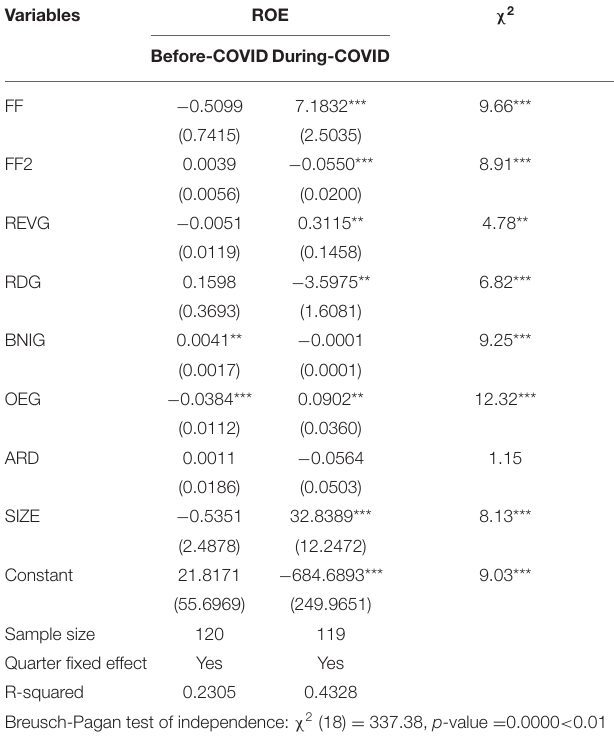
TABLE 2 | Regression results: before-coronavirus disease 2019 (COVID-19) vs. during-COVID-19. Variables